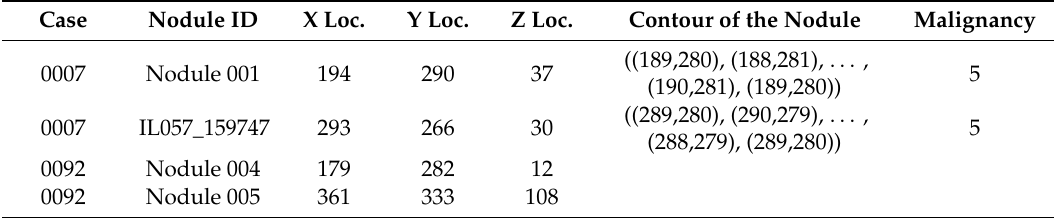
Table 1. Description from LIDC-IDRI.